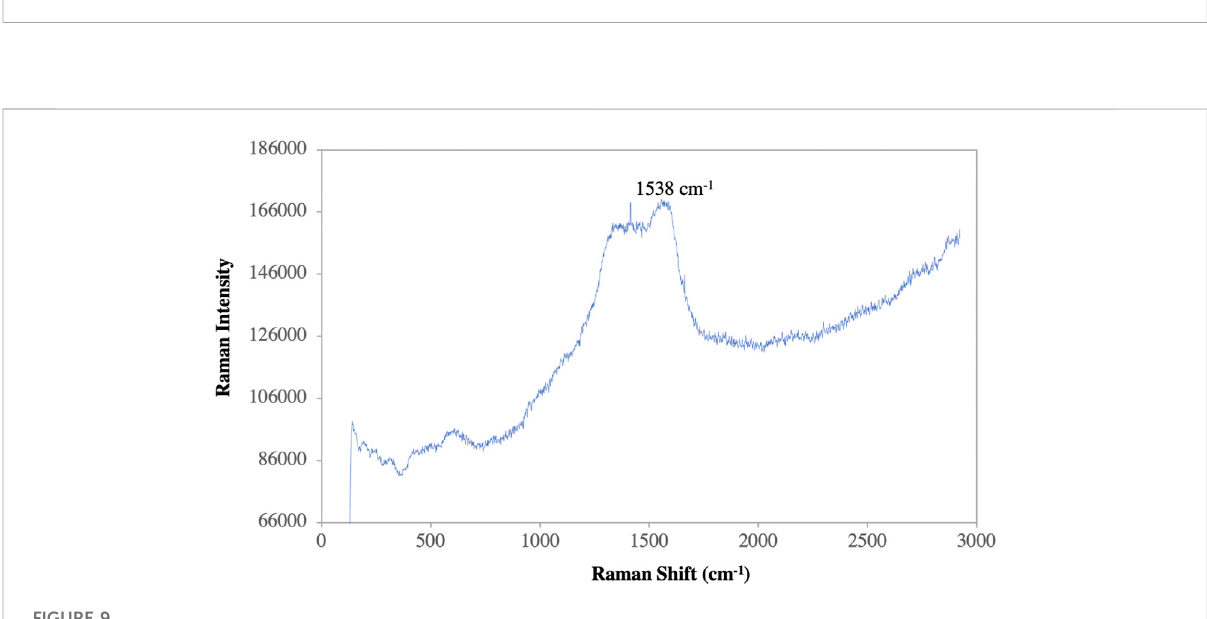
FIGURE 9 Raman spectroscopy of synthesized